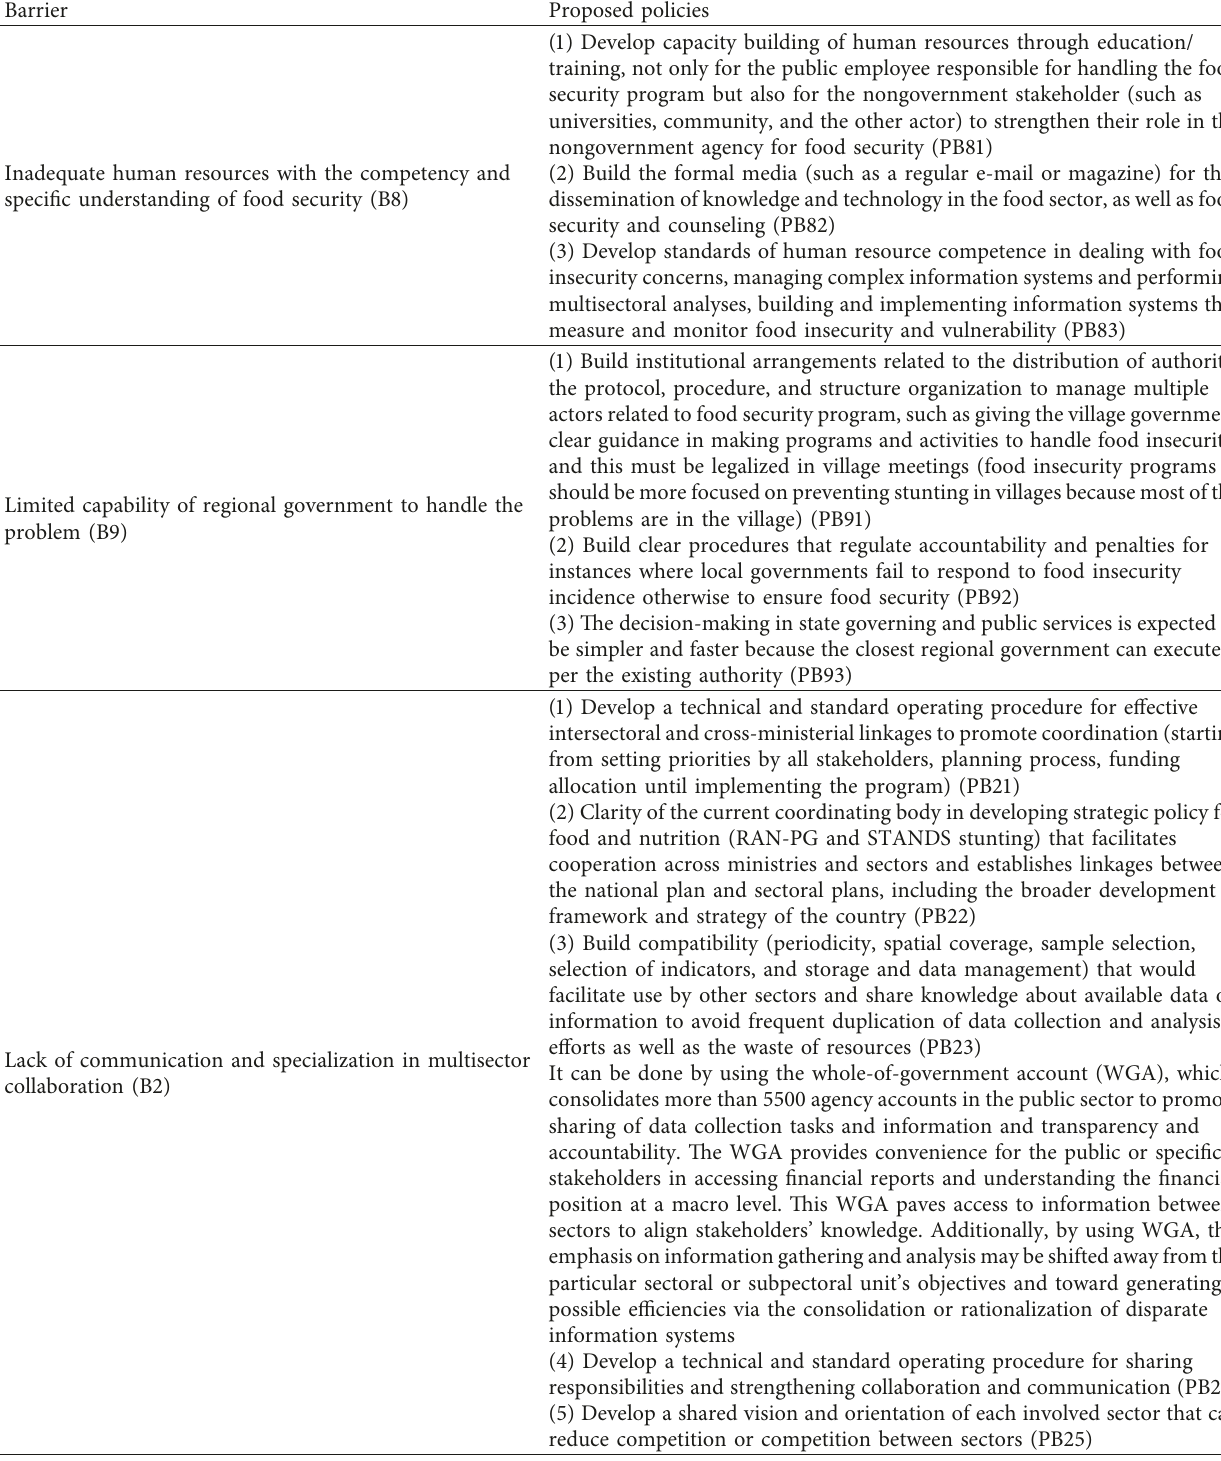
Table 12: The summary of proposed policies from six experts, the first round of the Delphi Method. Barrier Proposed